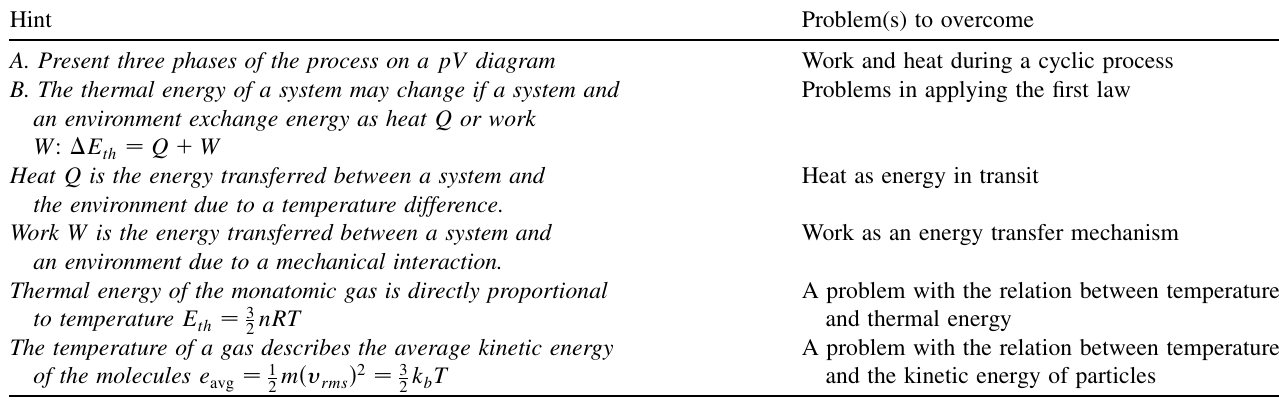
TABLE XIV. Hints offered to students. The hints are in chronological